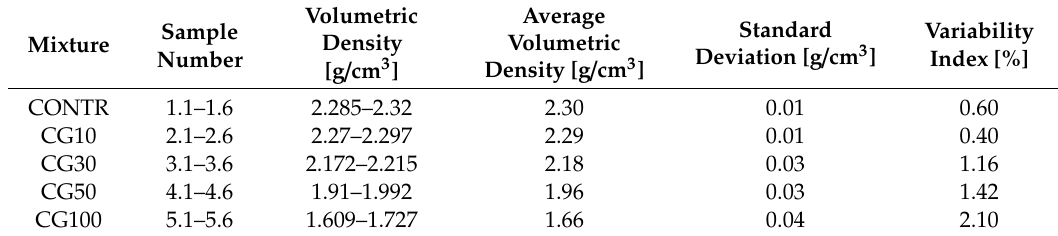
Table 9. Results of volumetric density testing of prepared